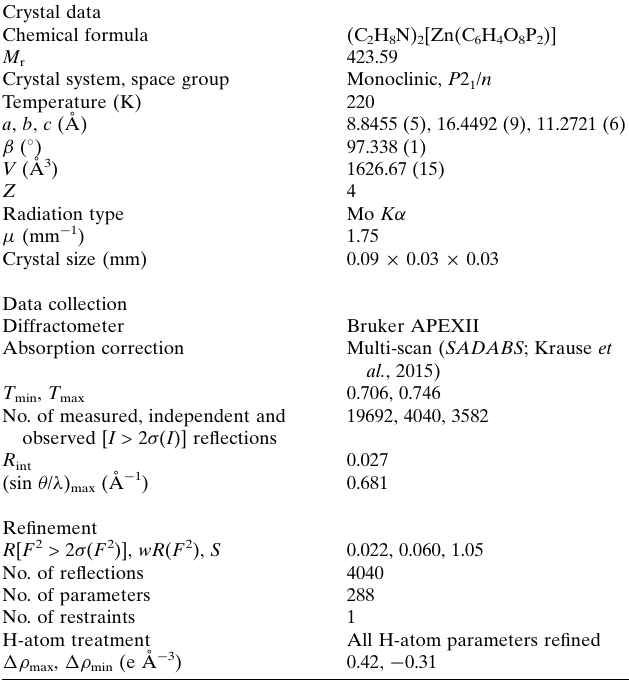
Crystal data Chemical formula